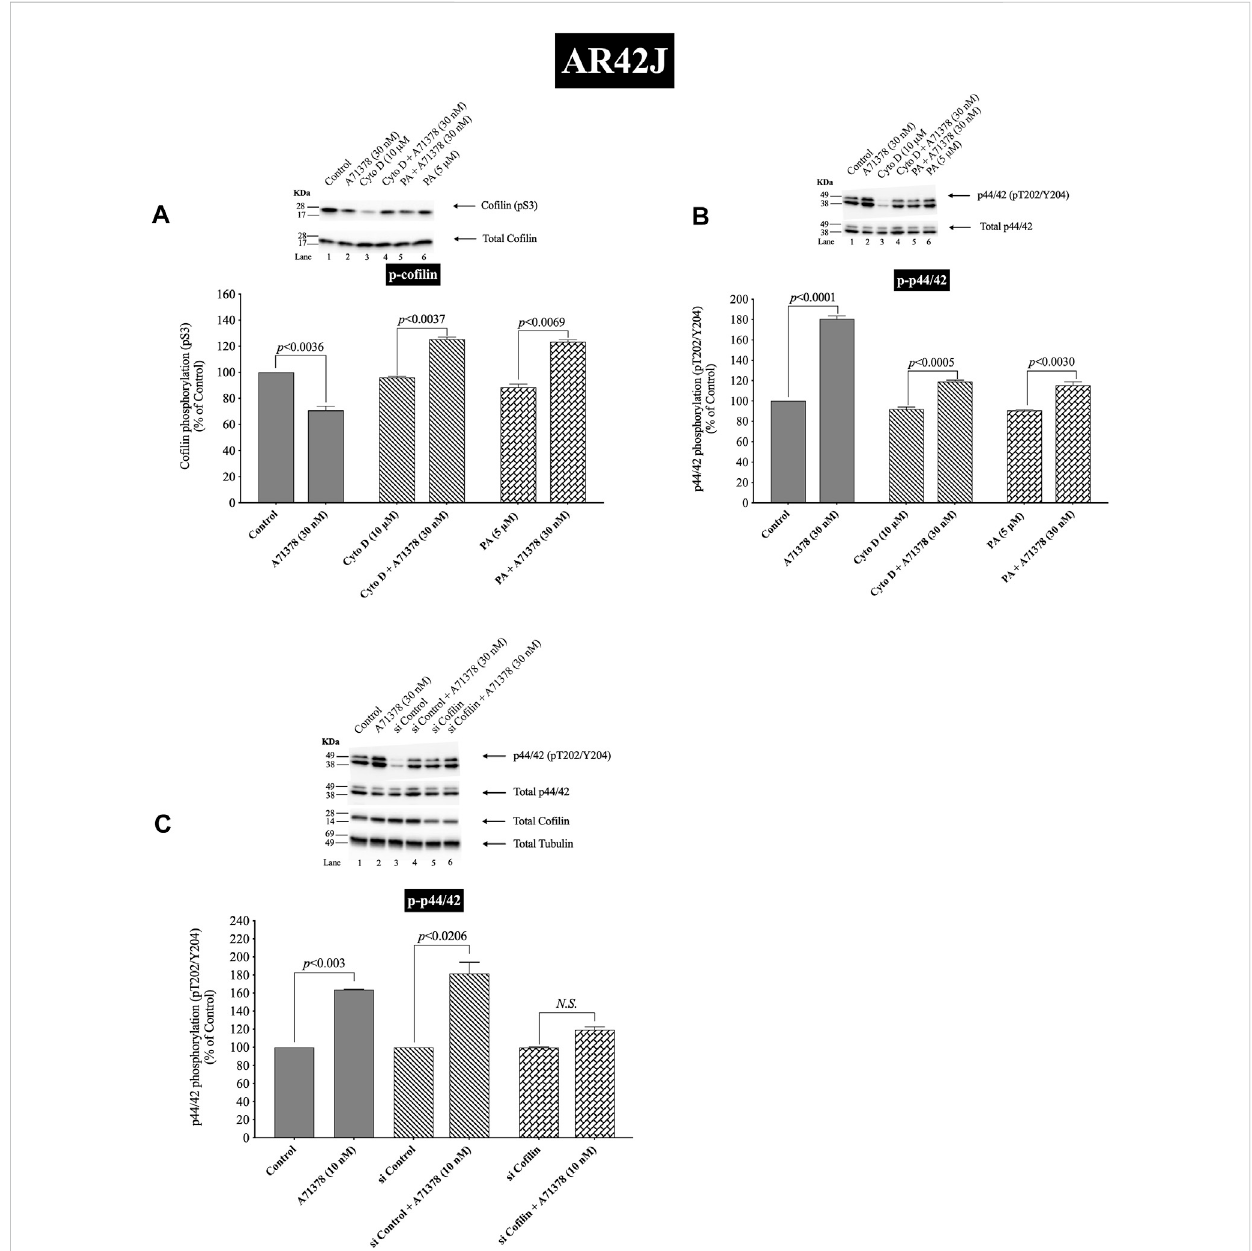
FIGURE 12 Effect of two co fi lin inhibitors, Cytochalasin D or Paclitaxel (A, B) , or co fi lin siRNA (C) , on the ability of A71378 (30 and 10 nM) to alter activation of co fi lin (A) and p44/42 (B, C) . In (A, B) AR42J cells were treated with Dexamethasone (100 nM) for 72 h and then incubated in the absence or presence of Cytochalasin D (10 µM) or Paclitaxel (5 µM) for 4 h and then incubated with no additions (control) A71378 (30 nM) for 10 min and then lysed. In (C) AR42J cells were treated with Dexamethasone (100 nM) for 72 h and transfected with siRNA non-targeting Control and siRNA against co fi lin for 48 h, and then incubated with no additions (control) and A71378 (10 nM) for 10 min and then lysed. Western blots were analyzed using anti-pS3 co fi lin, anti-pT202/Y204 p44/42 and Tubulin. Bands were visualized using chemiluminescence and quanti fi ed by densitometry. Top : Results of a representative blot of four independent experiments are shown. Bottom : Means ± S.E. of at least 4 independent experiments. Results are expressed as % of basal stimulation of the control group. N.S. , No signi fi cant.